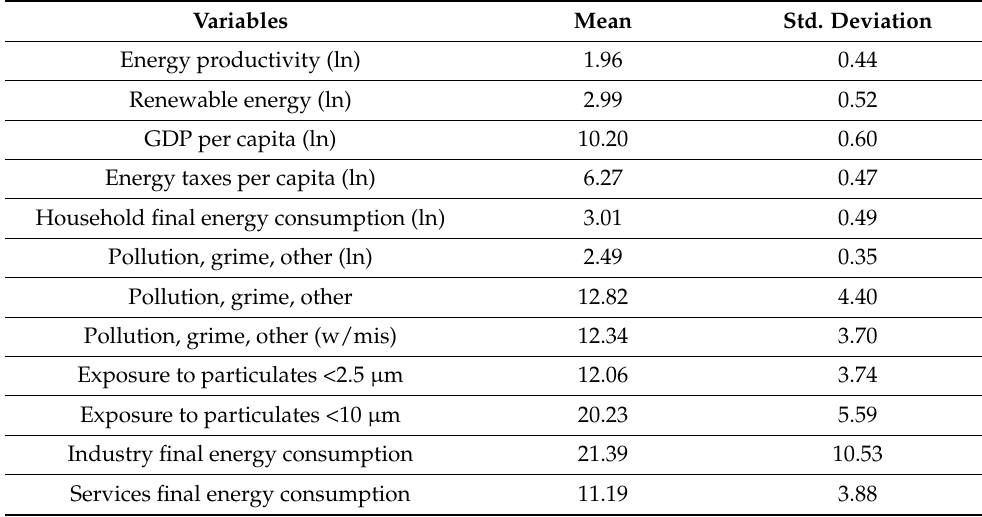
Table 3. Standardization values: means and standard deviations for transformed variables, 2019.